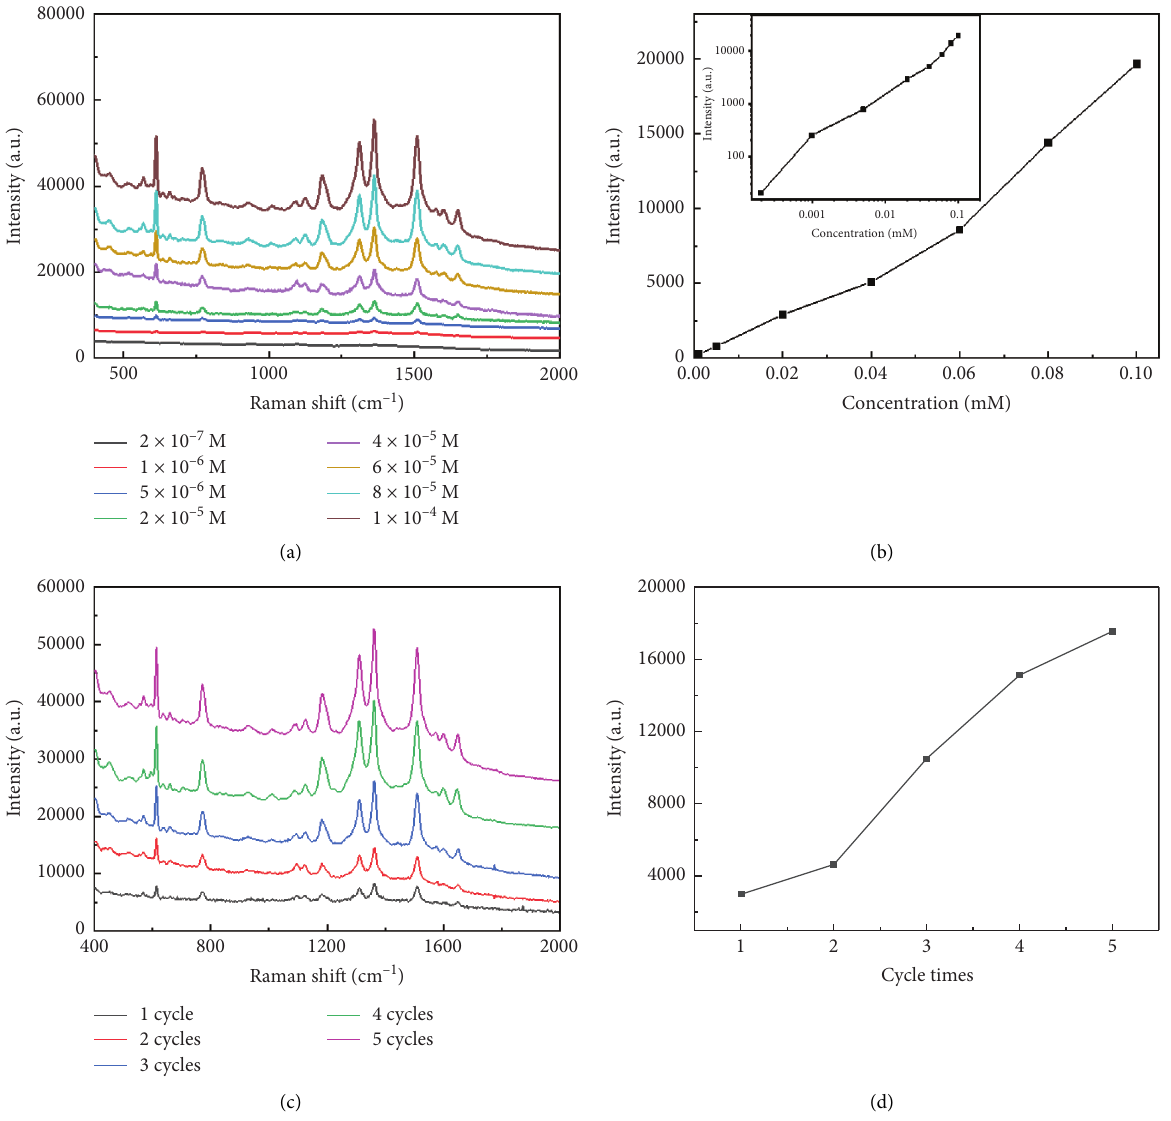
Figure 3: (a) The SERS spectra and (b) the 1364 cm − 1 peak intensity plot of different concentrations of Rh6G sampled by test strips with 3 cycles of fabrication and (c) the SERS spectra and (d) the 1364 cm − 1 peak intensity plot of 0.6 mM of Rh6G sampled by test strips with different fabrication